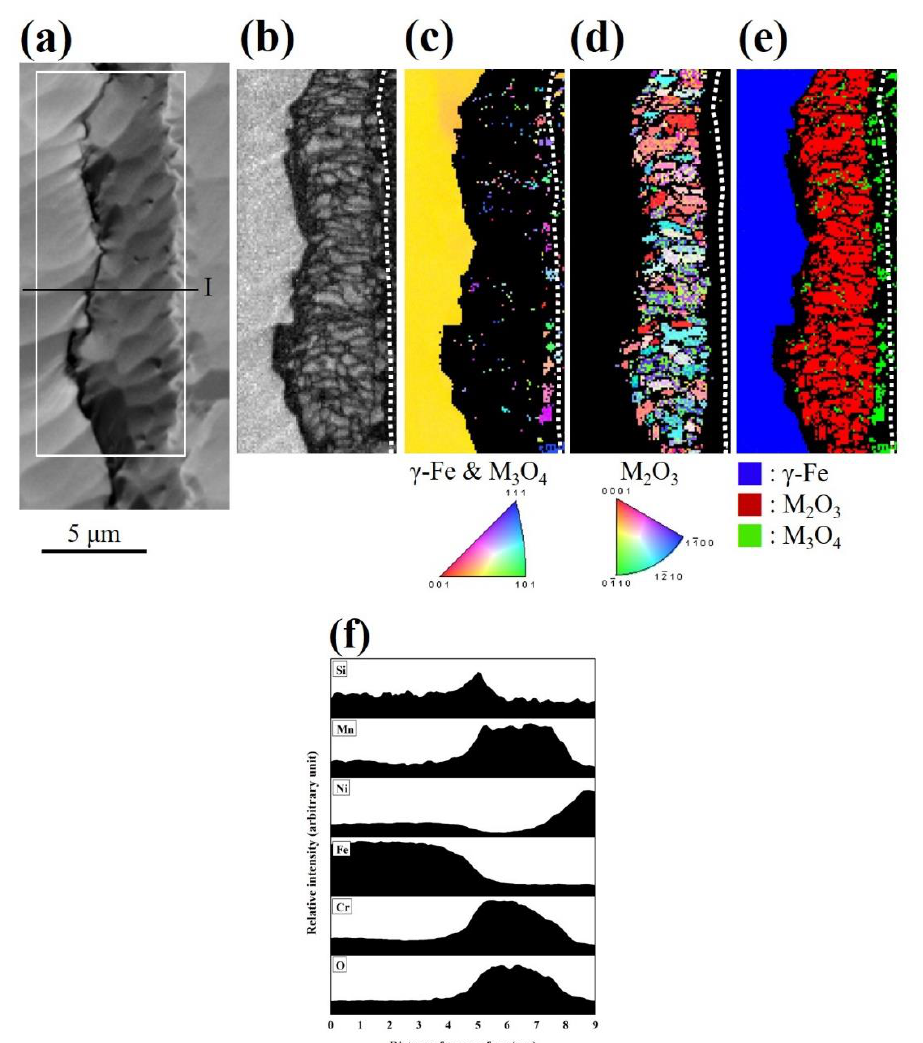
Figure 5. ( a ) Forward-scattered electron detector (FSD) image, ( b ) image quality map, ( c ) inverse pole figure map for γ and M 3 O 4 phases, ( d ) inverse pole figure map for M 2 O 3 phase, and ( e ) phase map of the oxide layers in 22Cr25NiWCoCu stainless steel with 0% Nb after oxidation in ambient air for 150 h. ( f ) EDS line scan of Si, Mn, Ni, Fe, Cr, and O along line I in ( a ).